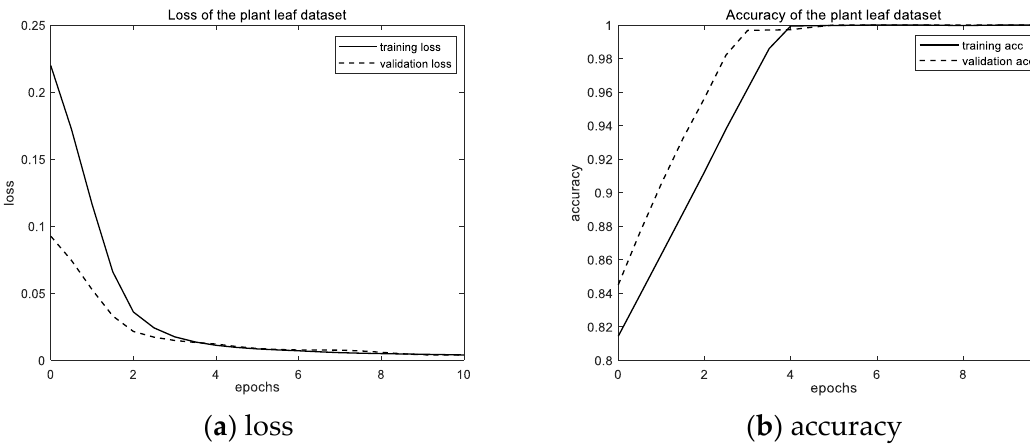
Figure 10. The loss and accuracy on the plant leaf dataset.